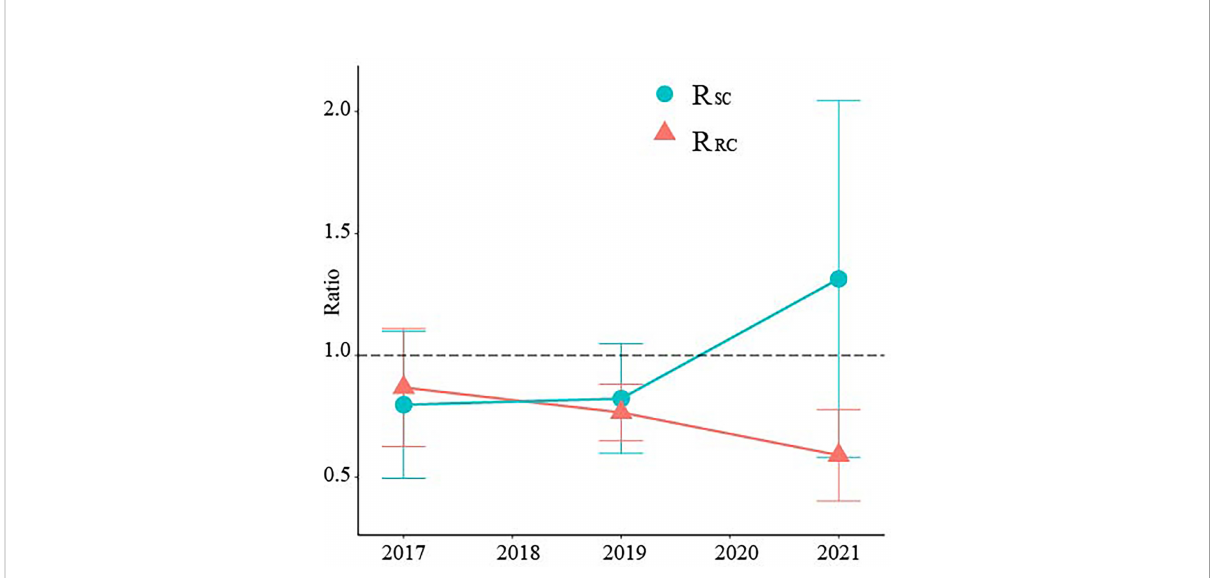
FIGURE 4 Ratio of aboveground productivity between different treatments in different years. RSC represents the aboveground productivity ratio of SC to CK; RRC represents the aboveground productivity ratio of RB to CK. Error bars indicate standard deviation (n =